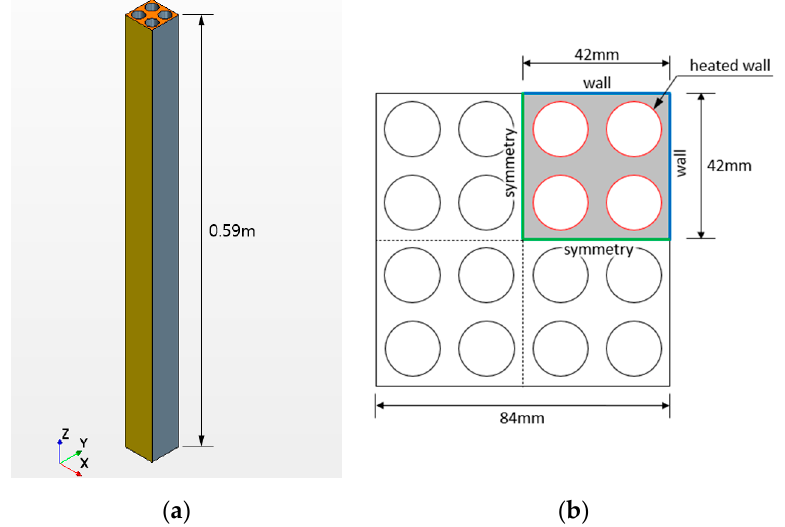
Figure 3. Shape of the rod bundle: ( a ) three-dimensional model viewed in the x–z plane and ( b ) cross-section of 0.58 m in height and wall conditions.